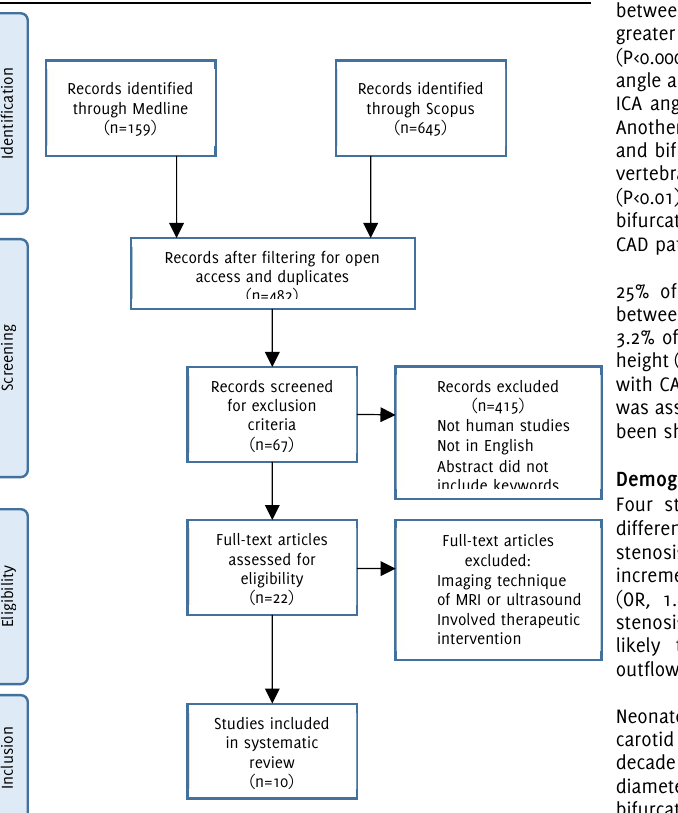
Figure 1. Flow diagram of study methodology with application of inclusion and exclusion